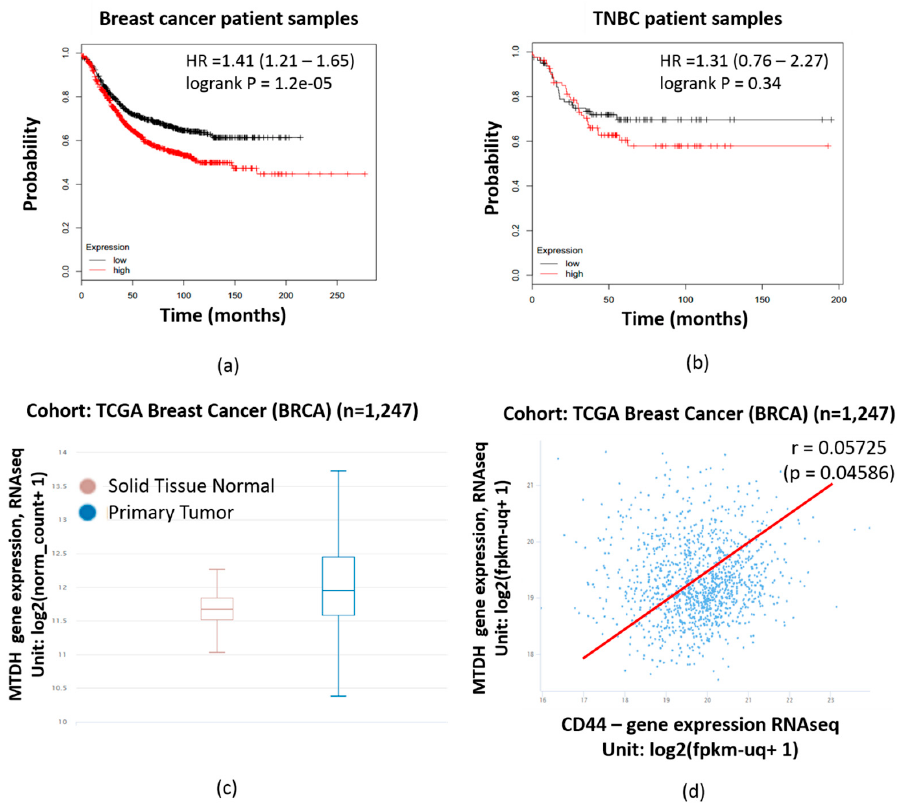
Figure 3. Analysis of metadherin (MTDH) expression in breast cancer patients. Correlation between MTDH expression and survival rate in total breast cancer patients ( a ) and triple negative breast cancer (TNBC) patients ( b ), as analyzed by Kaplan–Meier plotting. ( c ) MTDH expression in primary tumor and normal tissue in the The Cancer Genome Atlas (TCGA) breast cancer (BRCA) cohort. ( d ) Correlation between MTDH and CD44 expression, in the TCGA breast cancer (BRCA) cohort; * p < 0.05; results are presented as mean ± standard deviation.